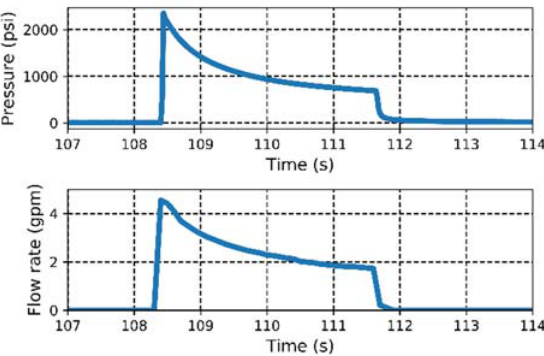
Figure 9. Pressure and flow rate while discharging.